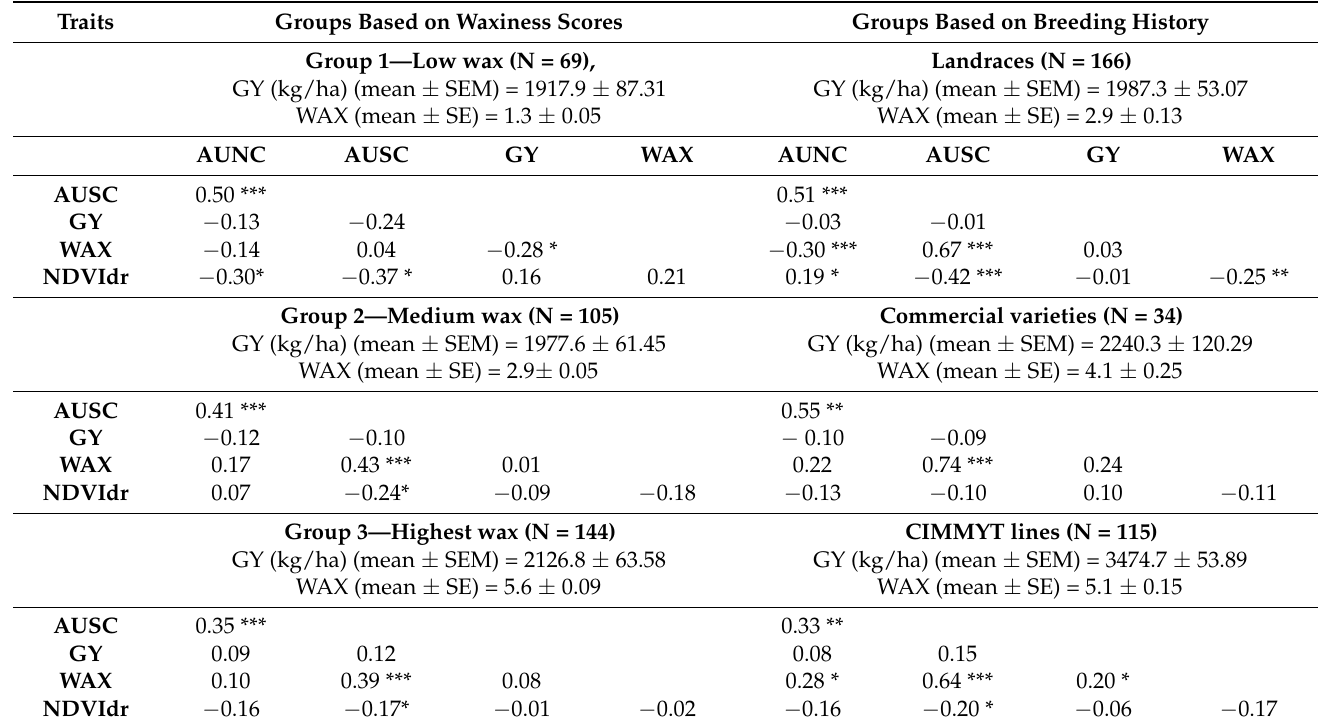
Table 3. Pearson correlations between pairs of phenotypic traits evaluated in field experiments conducted at the Elora Research Station (Canada) in 2017 (a wet year), after segregating the data based on waxiness scores and breeding histories.